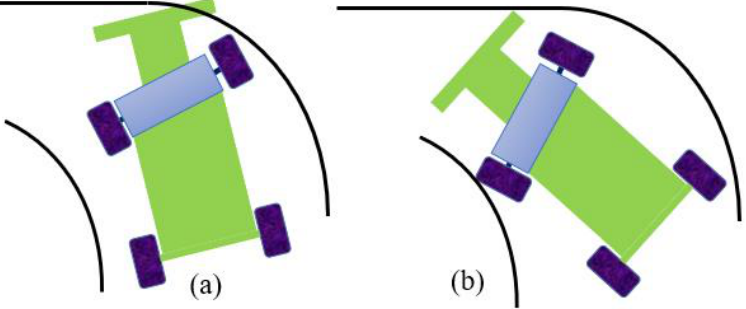
Figure 9. Schematic diagram of lane-touching conditions of the autonomous vehicle, ( a ) vehicle body crossing the track line not counting as off-track, and ( b ) wheel touching the lane marker counting as off-track.